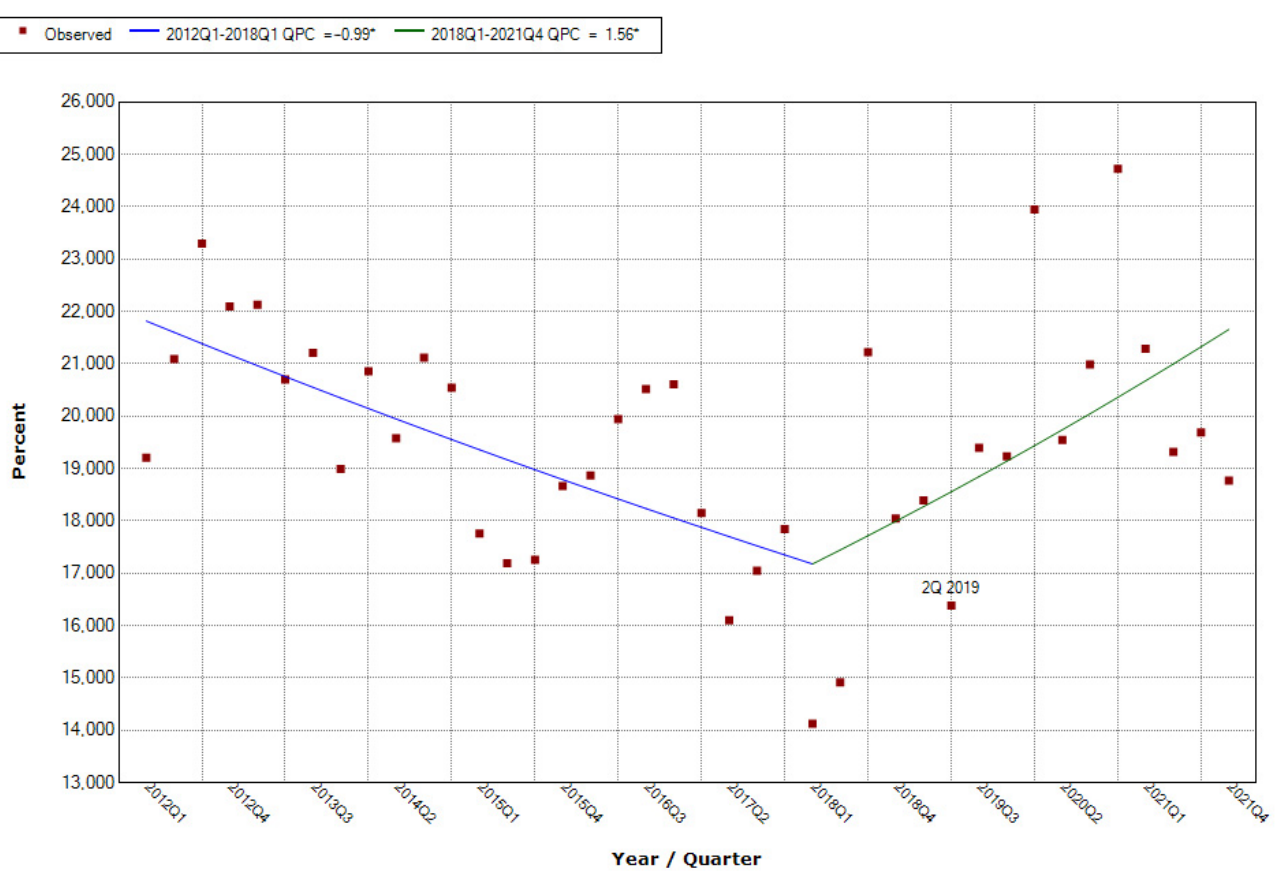
Figure A27. Percentage of products containing vitamin C in individual quarters in the period from 2012 to 28 November 2021. Joinpoints mark trend turning points. The date above the observation indicates the moment of publication of the scientific opinion/resolution.